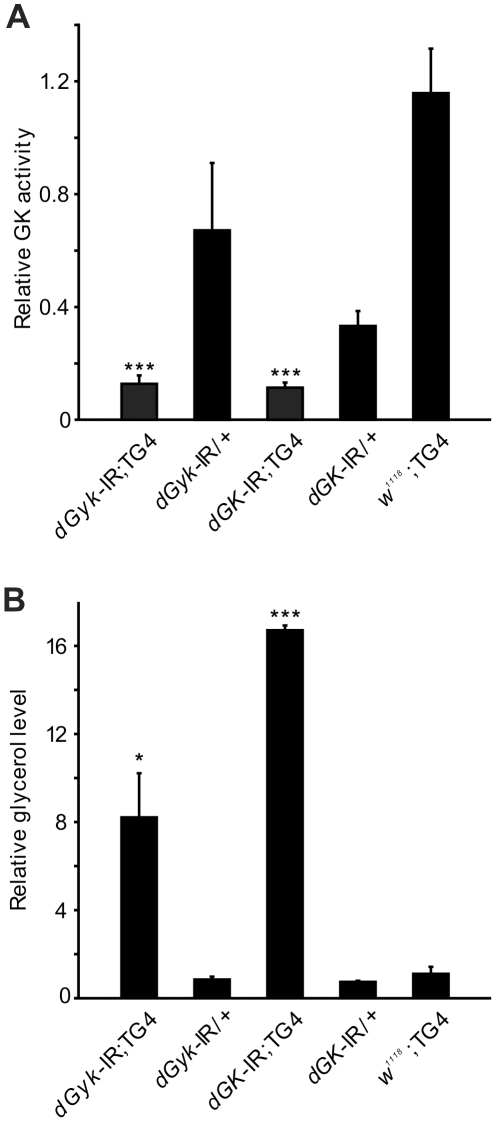
Quantification of glycerol kinase activity and glycerol.(A) Glycerol kinase activity was reduced in both dGyk-IR; Tub-GAL4 and dGK-IR; Tub-GAL4 3rd instar larvae compared to both parental controls w1118; Tub-GAL4 and construct control. (Note: Tub-GAL4 abbreviated to TG4) (B) Glycerol levels were elevated in both dGyk-IR; Tub-GAL4 and dGK-IR; Tub-GAL4 3rd instar larvae compared to parental controls. Error bars represent standard error between biological replicates. Statistical analysis using ANOVA was performed by comparison to parental controls. *P<0.05, **P<0.01, ***P<0.001.